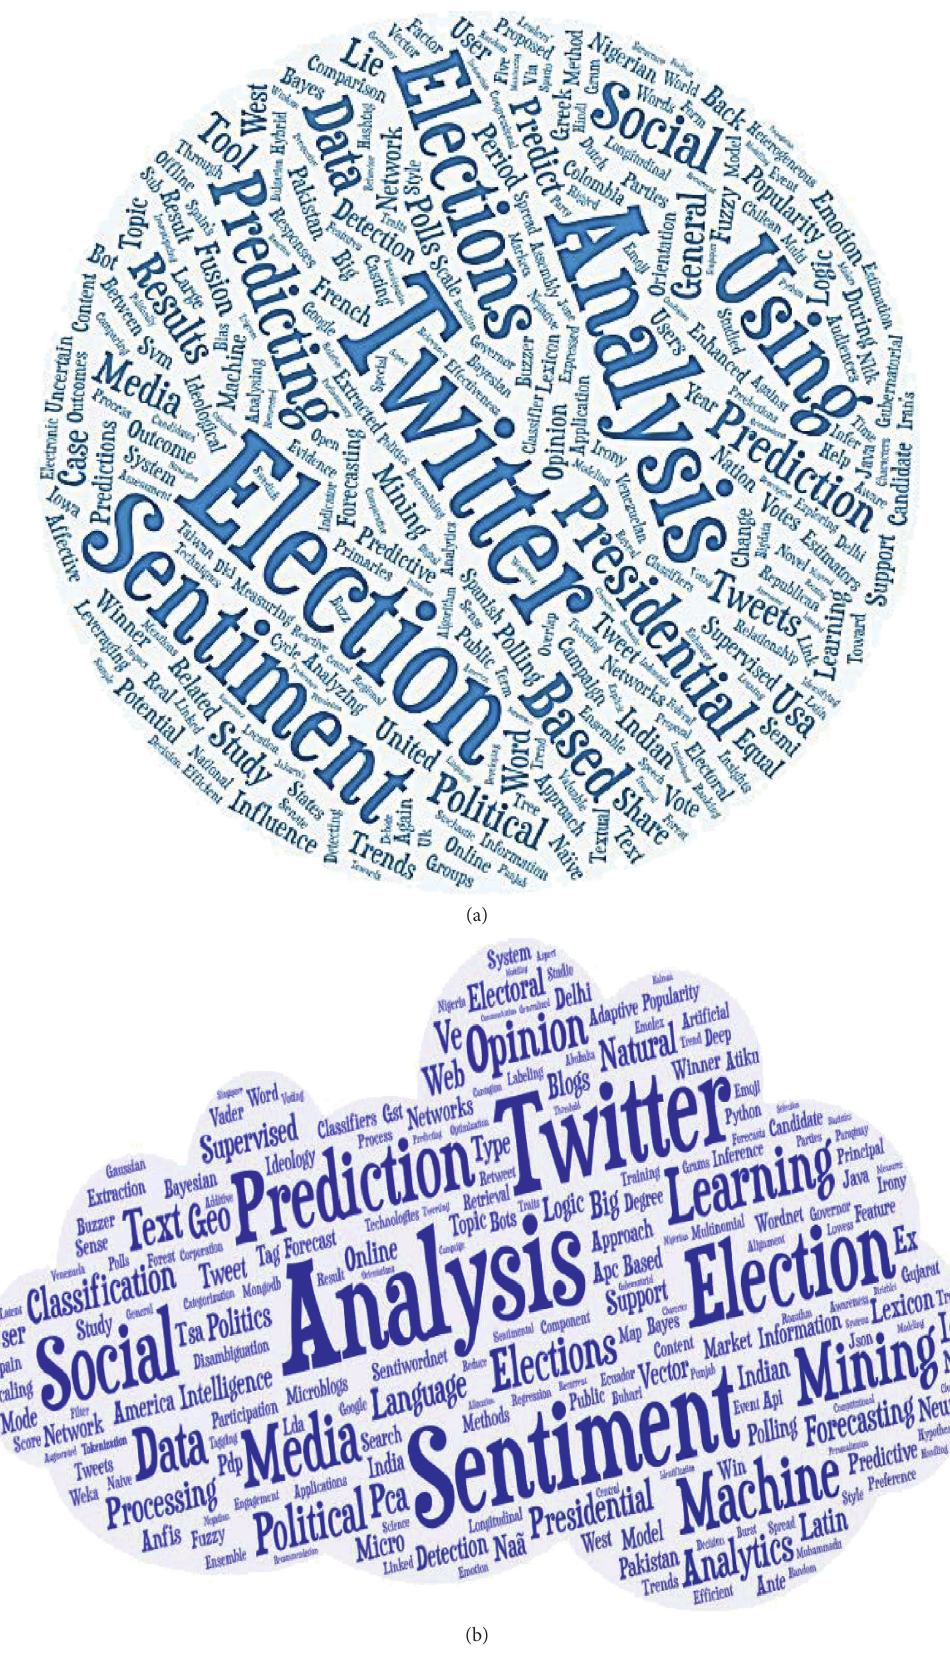
Figure 15: (a) Word cloud of the selected studies’ titles and (b) word cloud of the selected studies’ author